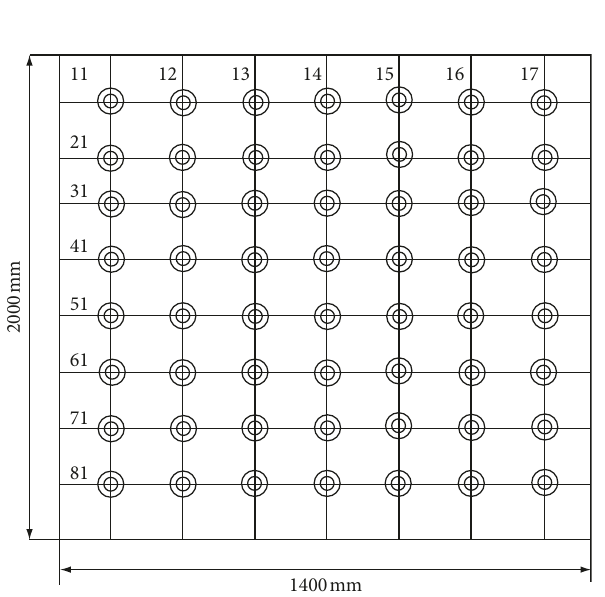
Figure 4: Layout of displacement measuring points for slope surface.